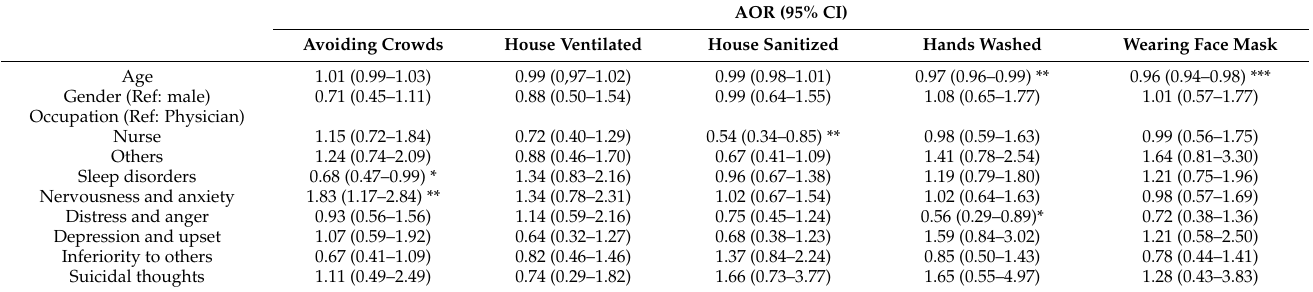
Table A2. Multiple logistic regression of predicting factors to preventive